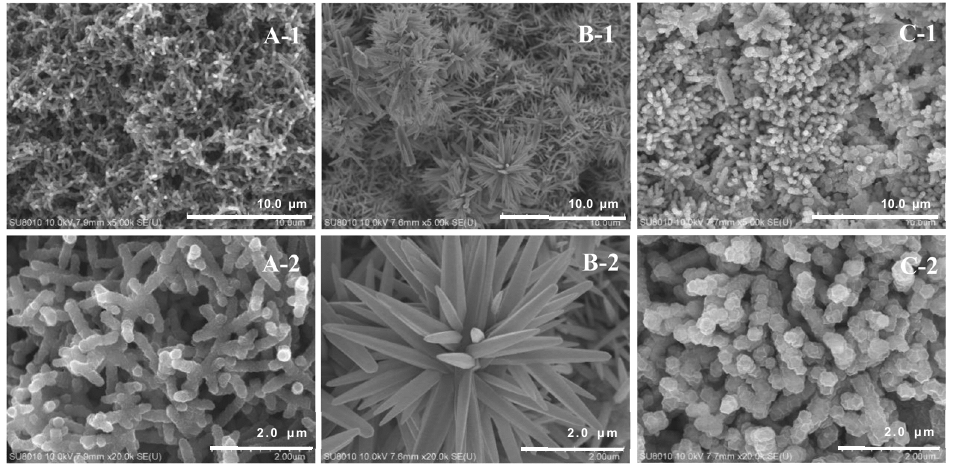
Figure 6. SEM images of stainless-steel wire coated with ( A ) GO:PANI, ( B ) GO:PANI/ZNRs, and ( C ) GO:PANI/ZNRs/ZIF − 8 (1; ×5000, 2; ×20,000). Comparing the adsorption amount by each synthesized step and PANI/ZNRs/ZIF − 8, GO:PANI/ZNRs/ZIF − 8 shows the highest adsorption for all target compounds (Figure